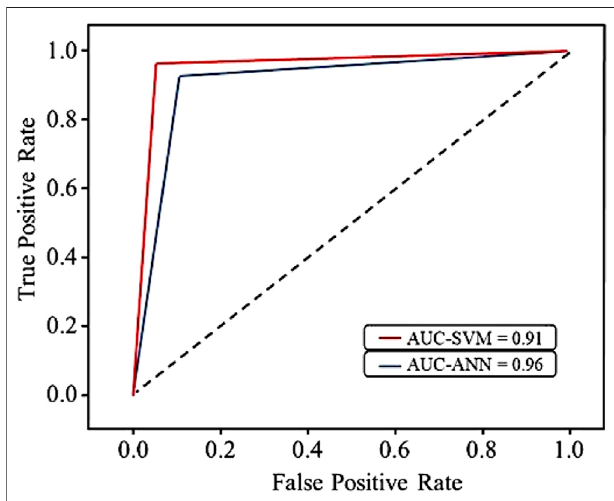
FIGURE 4 | Receiver Operating Characteristics (ROC) curves for the ANN and SVM